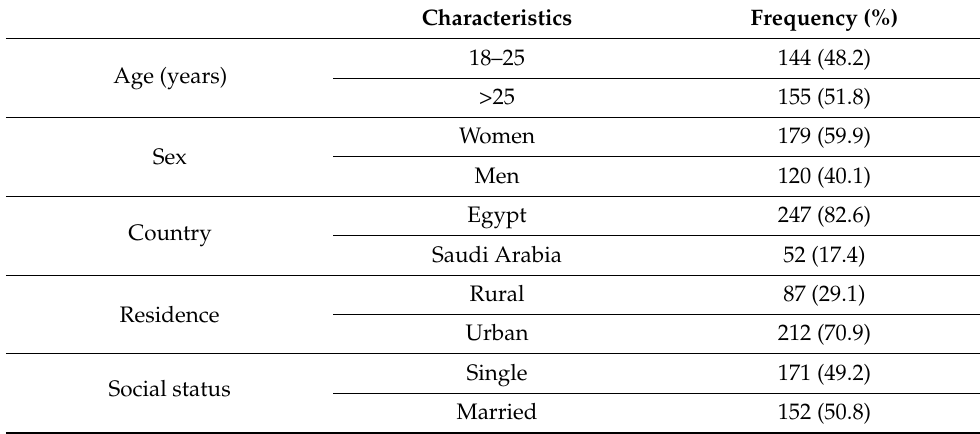
Table 1. Sociodemographic characteristics of participants ( n =